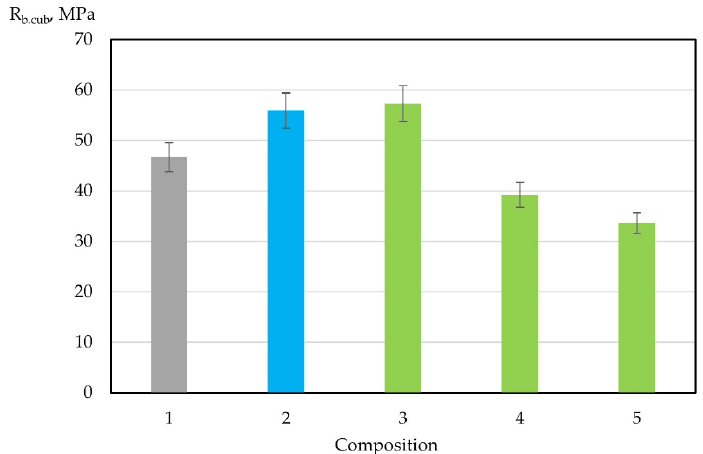
Figure 6. Change in compressive strength of concrete samples at the age of 28 days: 1 (grey)—control composition; 2 (blue)—electromagnetically treated cement paste without RSA; 3, 4, 5 (green)—electromagnetic treated cement paste with RSA of different dosage according to Table 6.